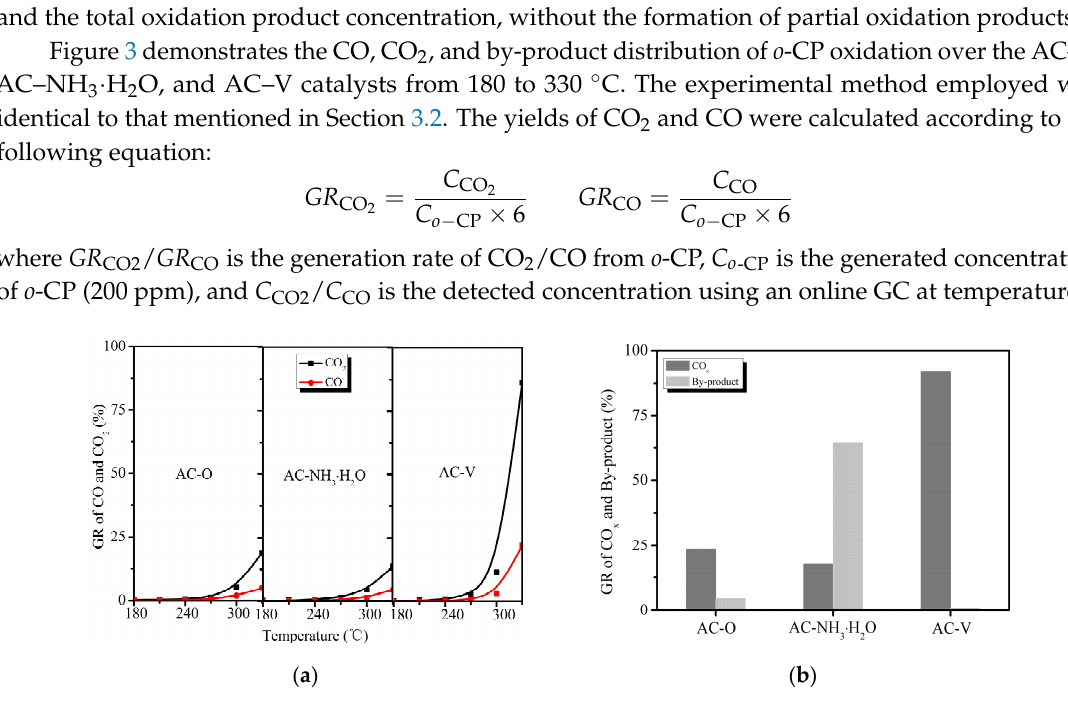
Figure 3. ( a ) Product distribution of CO and CO 2 , and ( b ) Removal efficiencies of by-products and CO x following catalytic oxidation of o -CP over three catalysts at 330 °C.